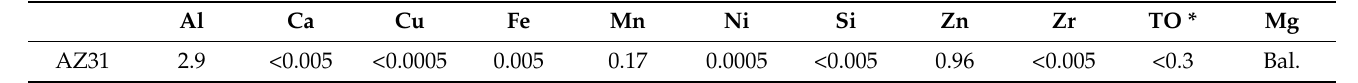
Table 3. Composition in wt.% of the AZ31 alloy used as a